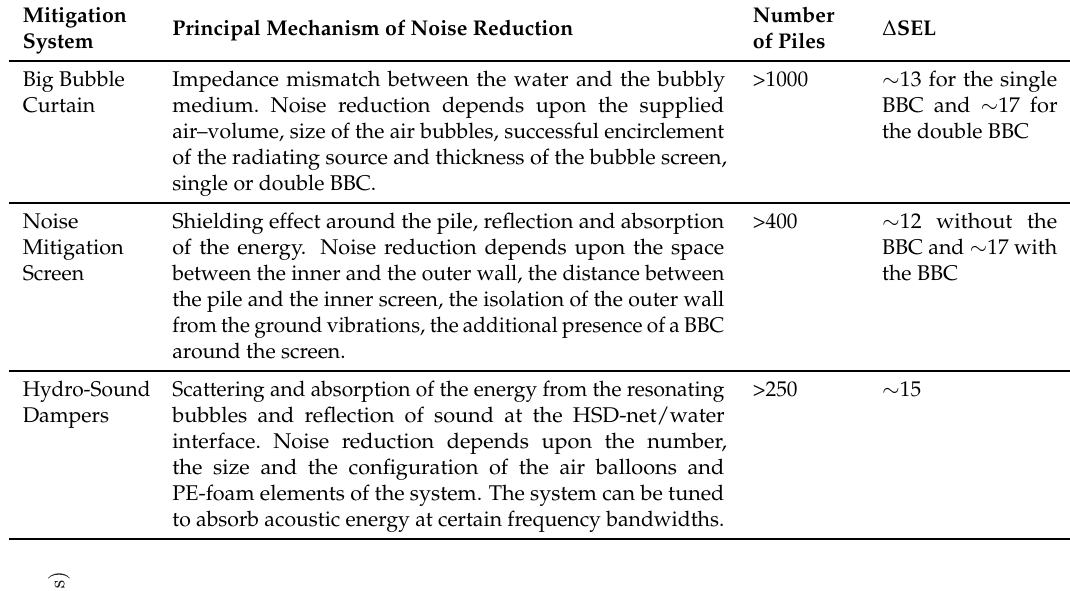
Table 3. Overview of the most widely used noise mitigation systems, their principal mechanism of noise attenuation, and their broadband noise reduction levels. Installed pile data reflect experience gathered until mid 2018.